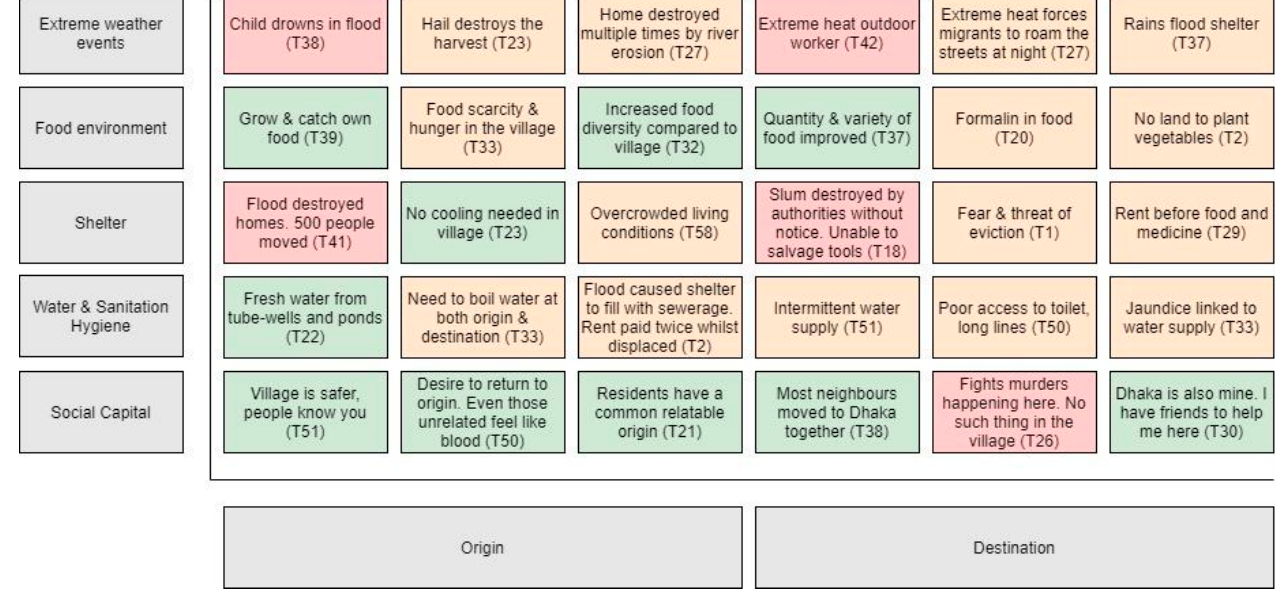
Figure 3. The climate change and health risk exchange at origin and destination. Heat map: This figure combines original data with an adapted version of a conceptual model by Warner et al. (2012) Figure 2: Household profiles affect whether migration is adaptive or erosive vis a vis rainfall, food, and livelihood insecurity.